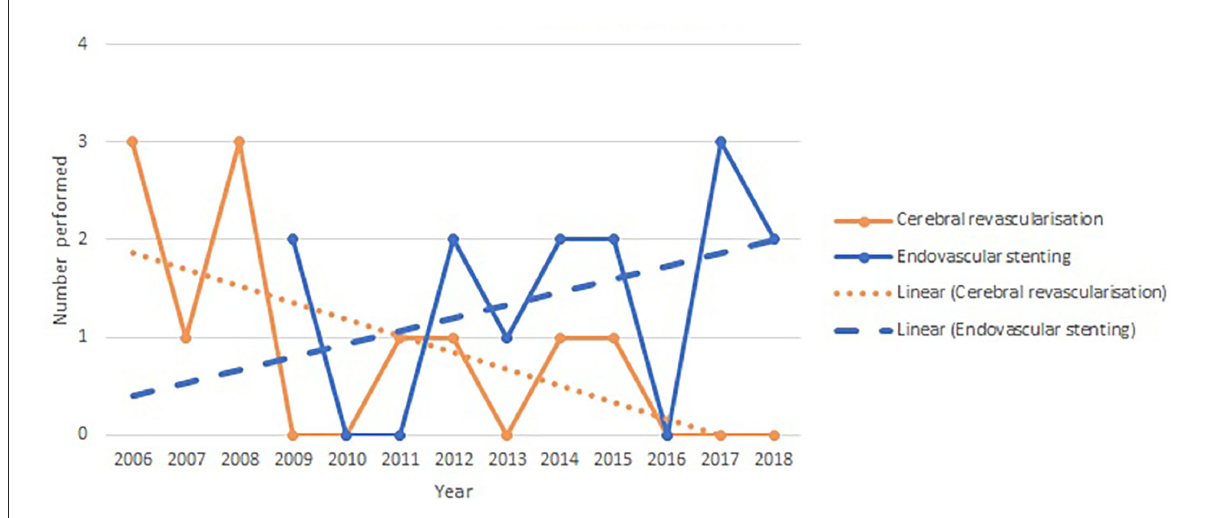
FIGURE2 Yearly incidence of cerebral revascularization and endovascular flow diversion surgery for giant and fusiform aneurysms.